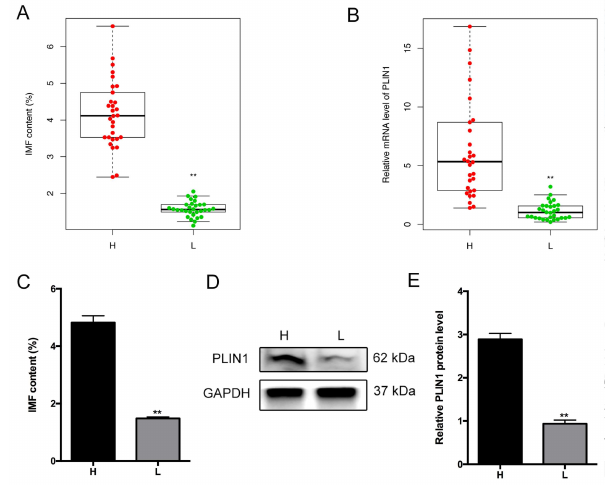
Figure 5. Expression level of PLIN1 gene between higher (H) and lower (L) intramuscular fat (IMF) groups. ( A ) IMF content; and ( B ) Real-time quantitative reverse transcription polymerase chain reaction (qRT-PCR) analysis of PLIN1 messenger RNA (mRNA) expression levels between H and L IMF groups ( n = 30). ** p < 0.01; ( C ) IMF content; and ( D , E ) Western blotting analysis for PLIN1 protein expression levels between H and L IMF groups ( n = 6).